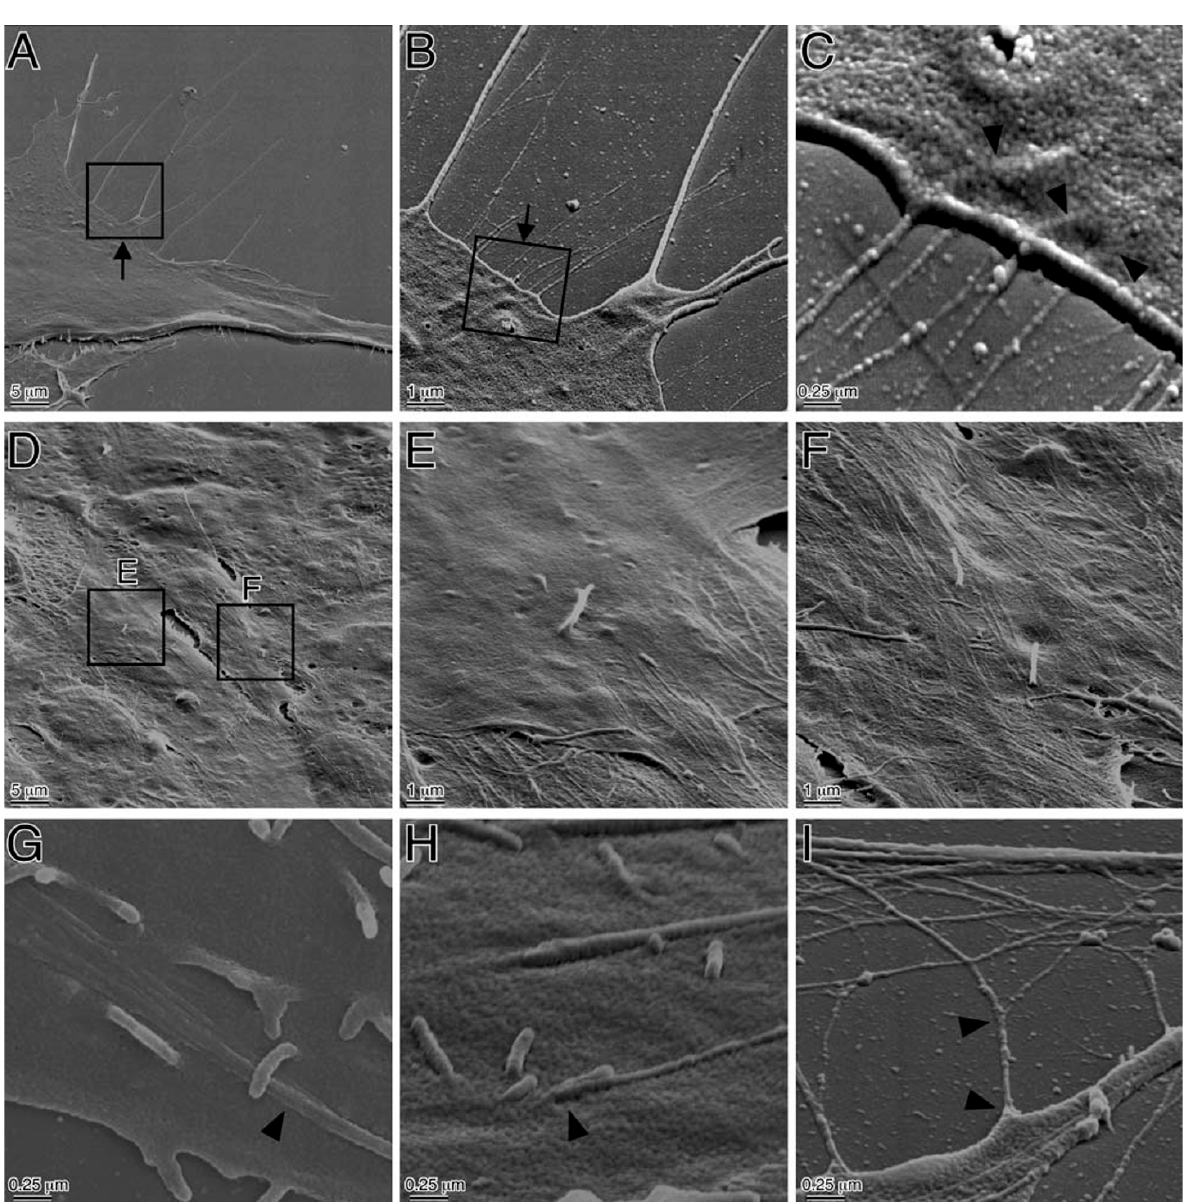
Figure 1 Scanning electron micrographs of NIH3T3 fibroblasts with a tilt angle 60 ° . (A-C) Exponentially growing NIH3T3 cells were seeded onto serum-coated glass coverslips at relatively low density (1 × 10 3 cells/cm 2 ) thereby avoiding cells to con- tact each other. After 48 hours, cells were fixed with 2% glutaraldehyde in PBS(+), and prepared for SEM as described in Mate- rials and Methods. (A) SEM image of NIH3T3 cell at low magnification. Note several micropodia, but not ultramicroextensions, at this magnification. (B) Higher magnification view of area indicated by square in A. Note that ultramicroextensions can be detected at this magnification. (C) Higher magnification view of area indicated by square in B. Sample was observed from the direction indicated by arrow in B. Note the diameter of ultramicroextensions is less than 0.05 µ m and some of the ultramicro- extensions appear to originate from a ridge of the cell body (arrowhead). (D-F) Cells were seeded onto serum-coated glass coverslips at 1 × 10 4 cells/cm 2 . After 1 week, cells were fixed with 2% glutaraldehyde in PBS(+) and prepared for SEM. (D) SEM image of NIH3T3 cell at low magnification. Note that cells are attached to each other and about half of the cell surface is not smooth. (E and F) Higher magnification view of area indicated by square in D. Note the numerous and parallel rather thin and long microextensions covering some of cell surface. (G-I) High magnification view of an NIH3T3 cell showing the origins of ultramicroextensions. They appear to grow from the tip of microextension in a broom-like fashion (G), from the cell surface like microvilli (H), or branch off from microextensions or ultramicroextensions